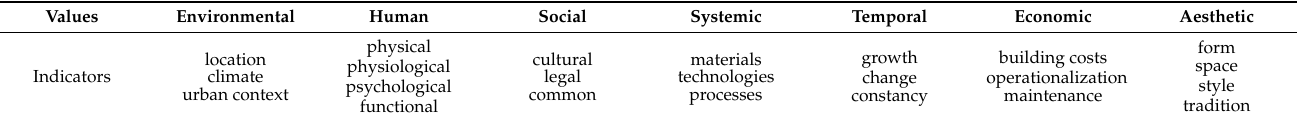
Table 1. Programming value matrix according to Herschberger